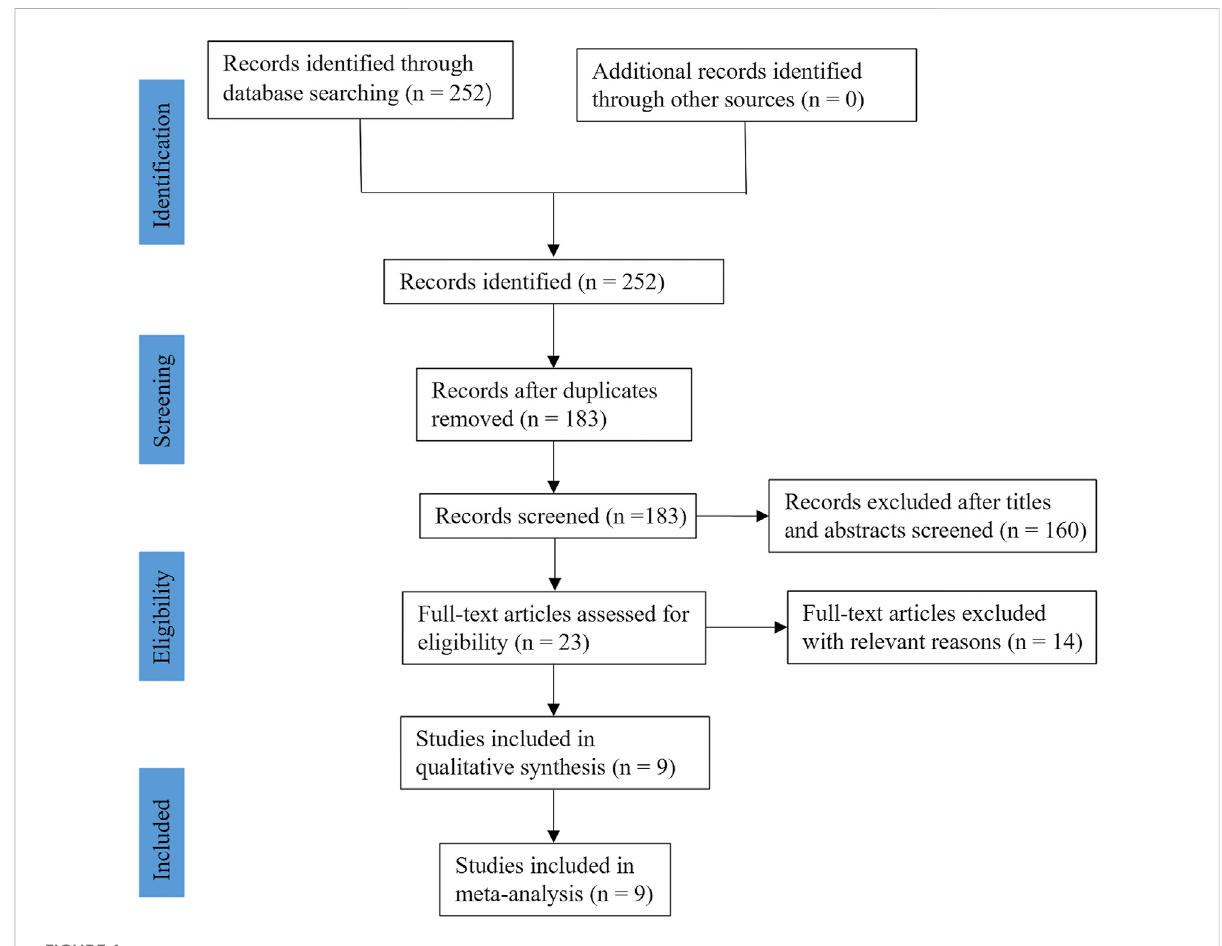
FIGURE 1 Flow chart of search and search